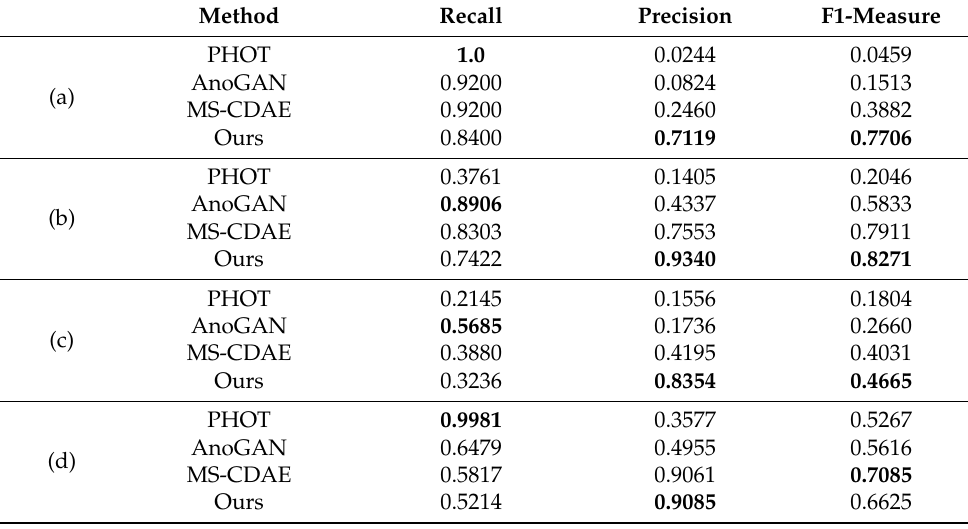
Table 4. Quantitative comparative results of Figure 7a–d between different